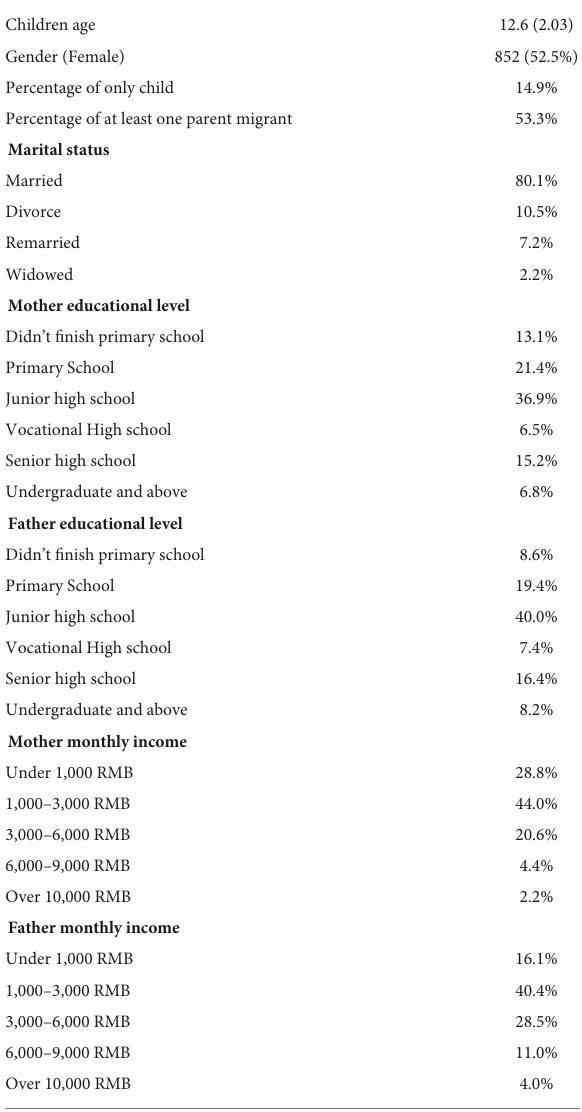
TABLE 1 Demographic information of the